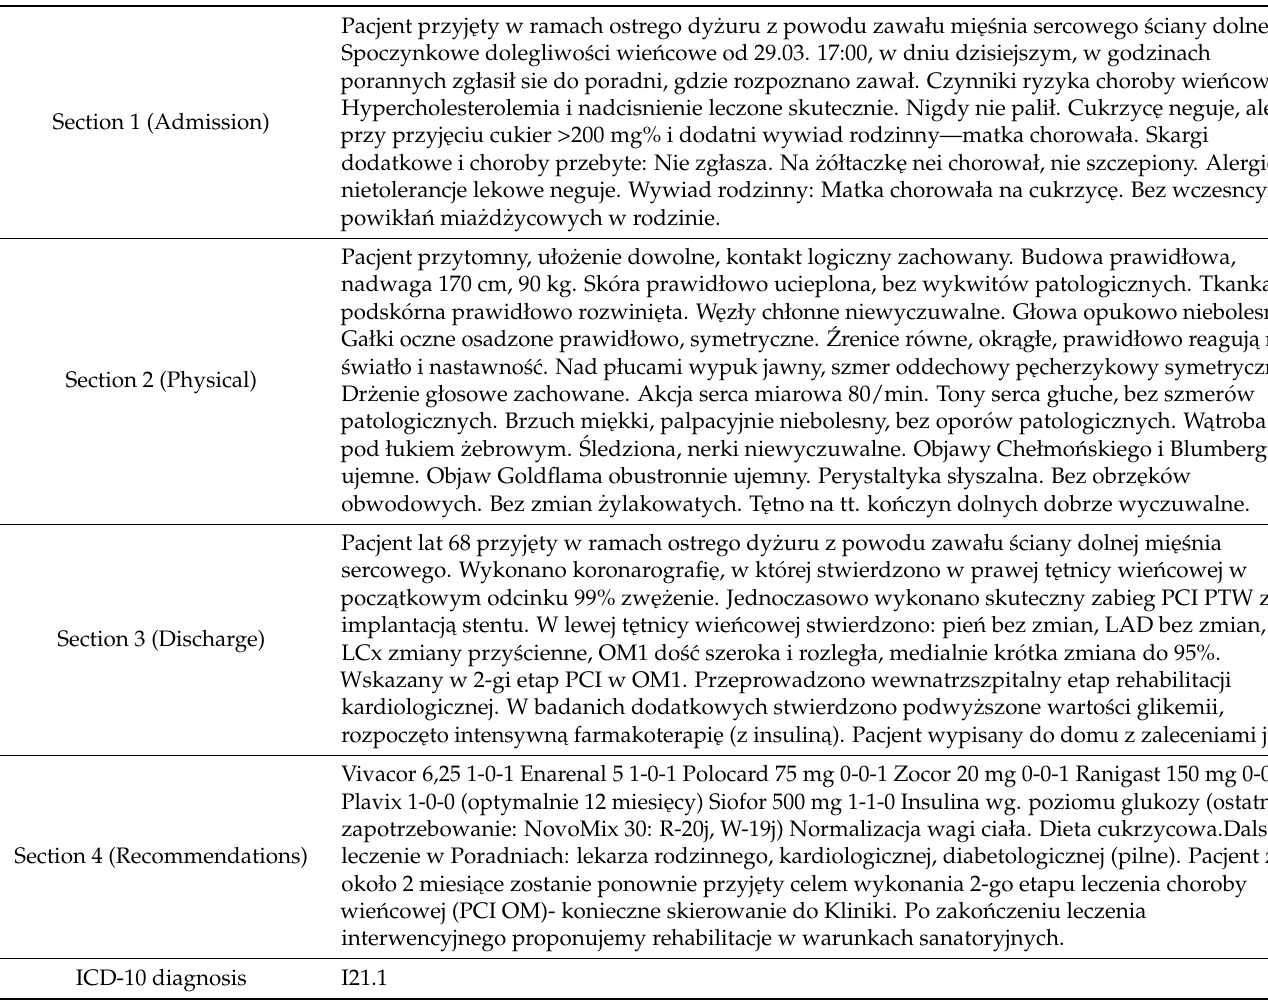
Table 2. Example of a complete health record in the Polish health record